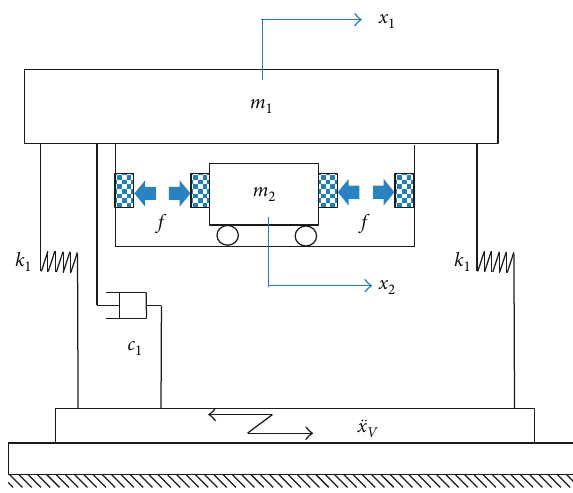
Figure 6: Systemic model of a jackup offshore platform with the magnet